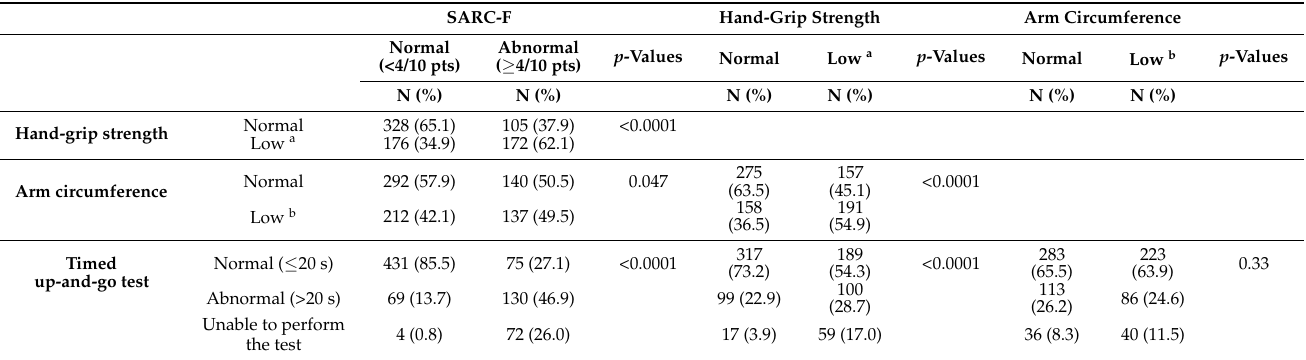
Table 2. Associations between four criteria for probable sarcopenia in older patients with cancer.